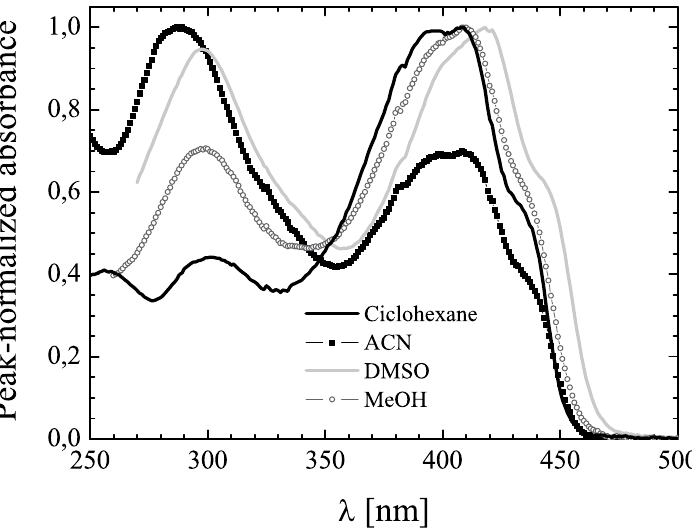
Fig 2. UV-Vis absorption of K2T23. Absorption spectral line-shapesof K2T23 dissolvedin cyclohexane (line), acetonitrile (squares), dimethylsulfoxide (crosses), and methanol(circles).